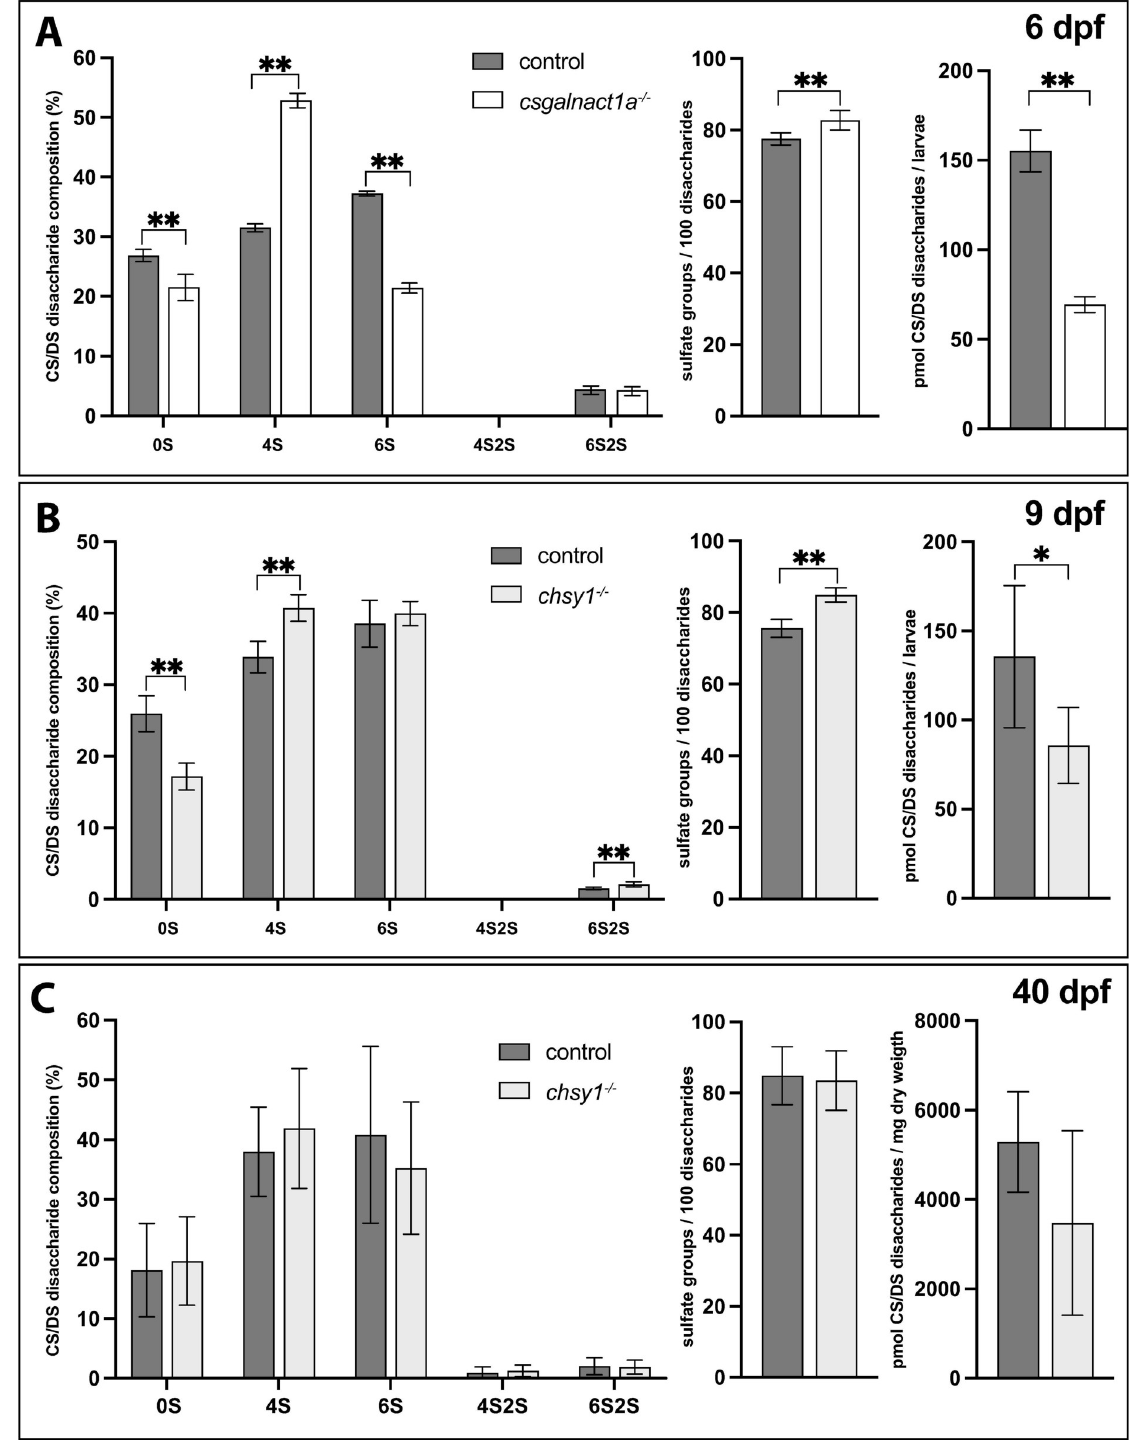
Fig 7. RPIP-HPLC analysis shows the CS/DS disaccharide composition (left charts), total sulfate group content/100 disaccharides (middle charts) and amount of CS/DS (right charts) for 6 dpf larvae (A), 9 dpf larvae (B) and 40 dpf juveniles (C). Statistical significances are indicated with � for p-values < 0.05 and �� for p-values < 0.005. Disaccharide species abbreviated as 0S ( Δ HexA- GalNAc/ Δ HexA-GlcNAc), 4S ( Δ HexA-GalNAc4S), 6S ( Δ HexA-GalNAc6S), 4S2S ( Δ HexA2S-GalNAc4S), and 6S2S ( Δ